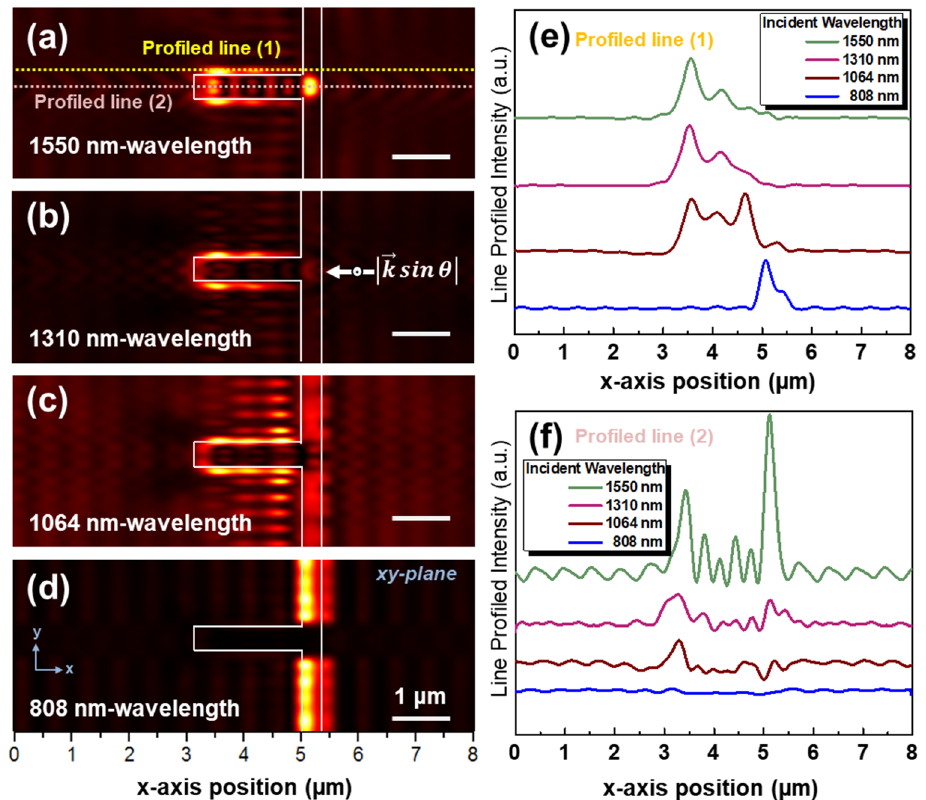
Figure 3. Simulation results of plasmonic near-field electromagnetic fields distributions for T-shaped nanostructure arrays by incident light with wavelengths of ( a ) 1550, ( b ) 1310, ( c ) 1064, and ( d ) 808 nm. Intensities of localized electromagnetic fields at ( e ) the edge (profiled line (1)) and ( f ) the center (profile line (2)). The information of incident light source is indicated in ( b ).